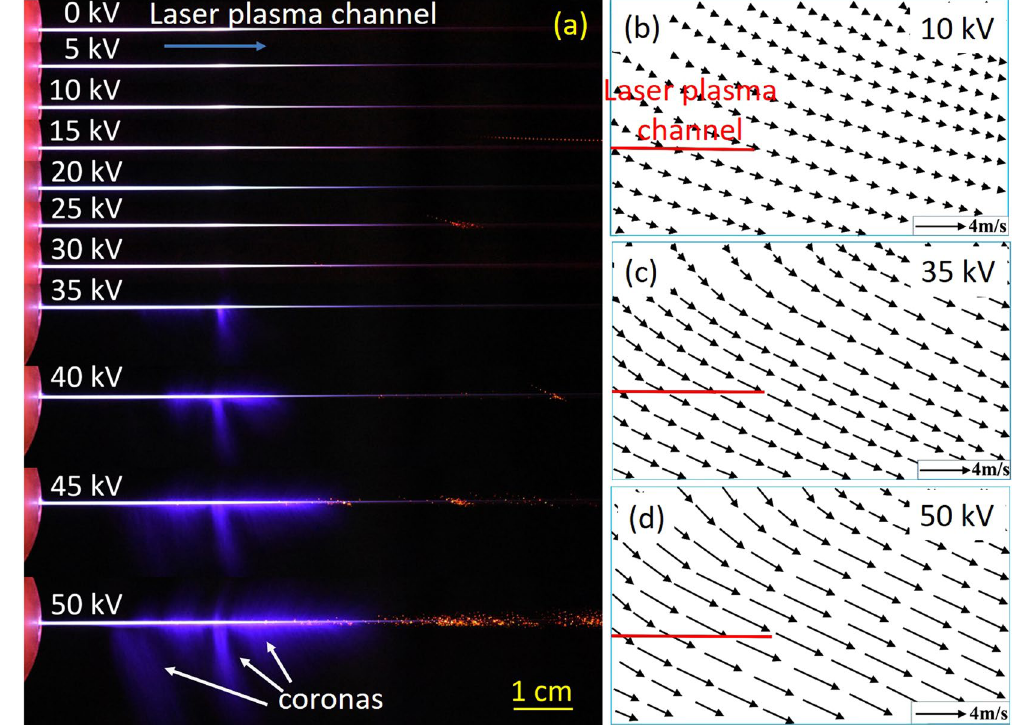
Figure 2. ( a ) Real-color images of discharges generated along the laser plasma channel in air with applied voltages ranging from 0 kV to 50 kV, and ( b – d ) the 2D flow fields of the ionic wind at the voltages of 10 kV, 35 kV, and 50 kV, respectively. Clear discharges guided by laser were assigned by the arrows. The recording parameters of the camera for ( b – d ) are S = 1/50 s, F = 4, and ISO = 25600 ( b ) S = 1/200 s, F = 4, and ISO = 25600 ( c ) S = 1/500 s, F = 4, and ISO = 25600 ( d ), respectively.